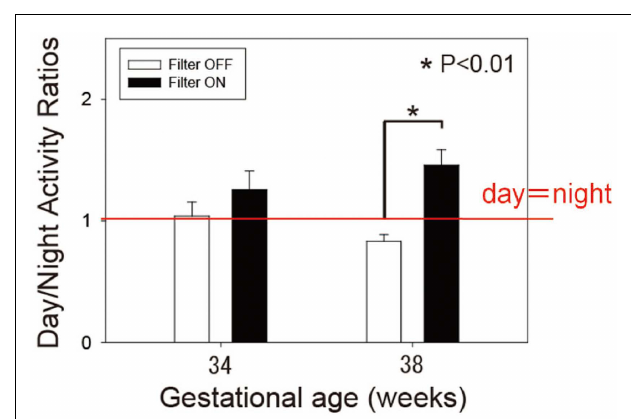
FIGURE 11 | Day-night activity ratios of preterm infants of 34 and 38weeks’ gestational age .White bars represent control infants without filter. Dark bars represent experimental group infants with a filter. Observe that filter cover at nights results in more daytime than nighttime activity at